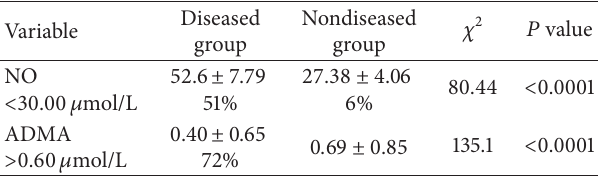
Table 3: Parameters taking CAD as dependent